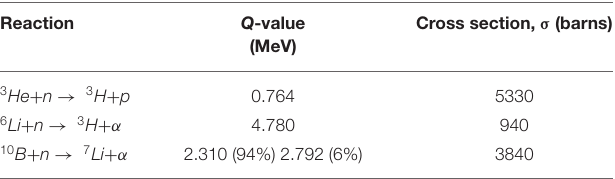
TABLE 1 | The thermal neutron reaction and the corresponding Q -values and absorption cross sections. Reaction Q -value Cross section, σ (barns) (MeV)